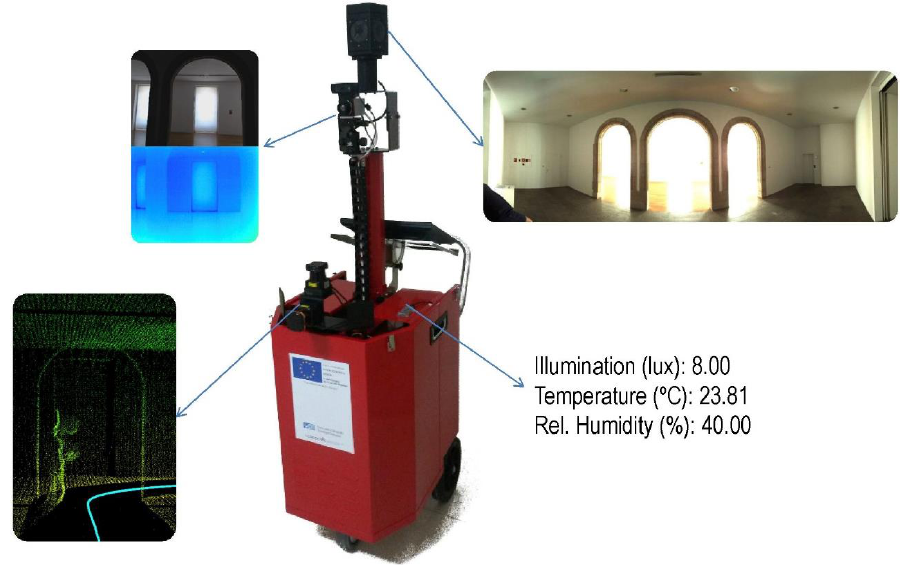
Figure 1. Indoor Multi-sensor Acquisition System.